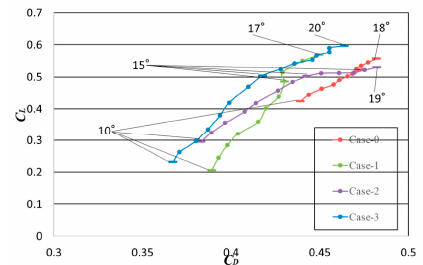
Figure 8. The polar curve of the elliptic cylinder clothed with ski jumping suit fabric at Re = 1.0 × 10 5 .